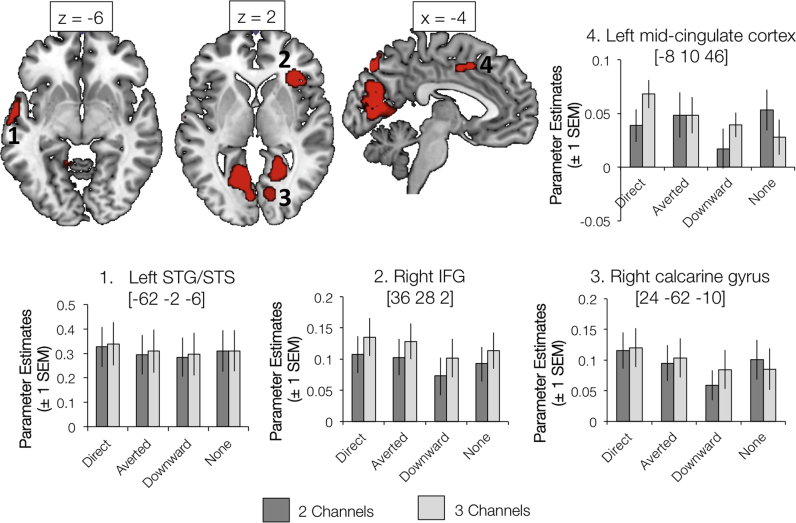
Significant clusters showing a main effect of Gaze Direction. Activations are shown at a voxel height threshold of p<0.005 and a corrected cluster extent threshold of p<0.001 (Slotnick et al., 2003). Plots show parameter estimates (±1 S.E.M.) taken from 4 mm-radius spherical regions-of-interest built around selected peak voxels (using the MarsBaR toolbox in SPM; Brett et al., 2002). Coordinates are given in Montreal Neurological Institute stereotactic space.